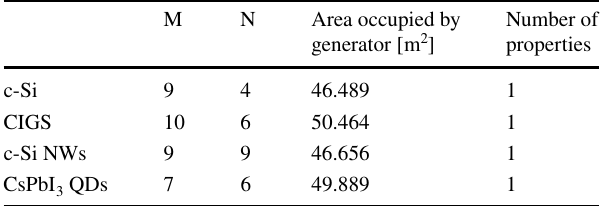
Fig. 10 External conditions data in Vila Real Table 5 Photovoltaic system sizing for the three